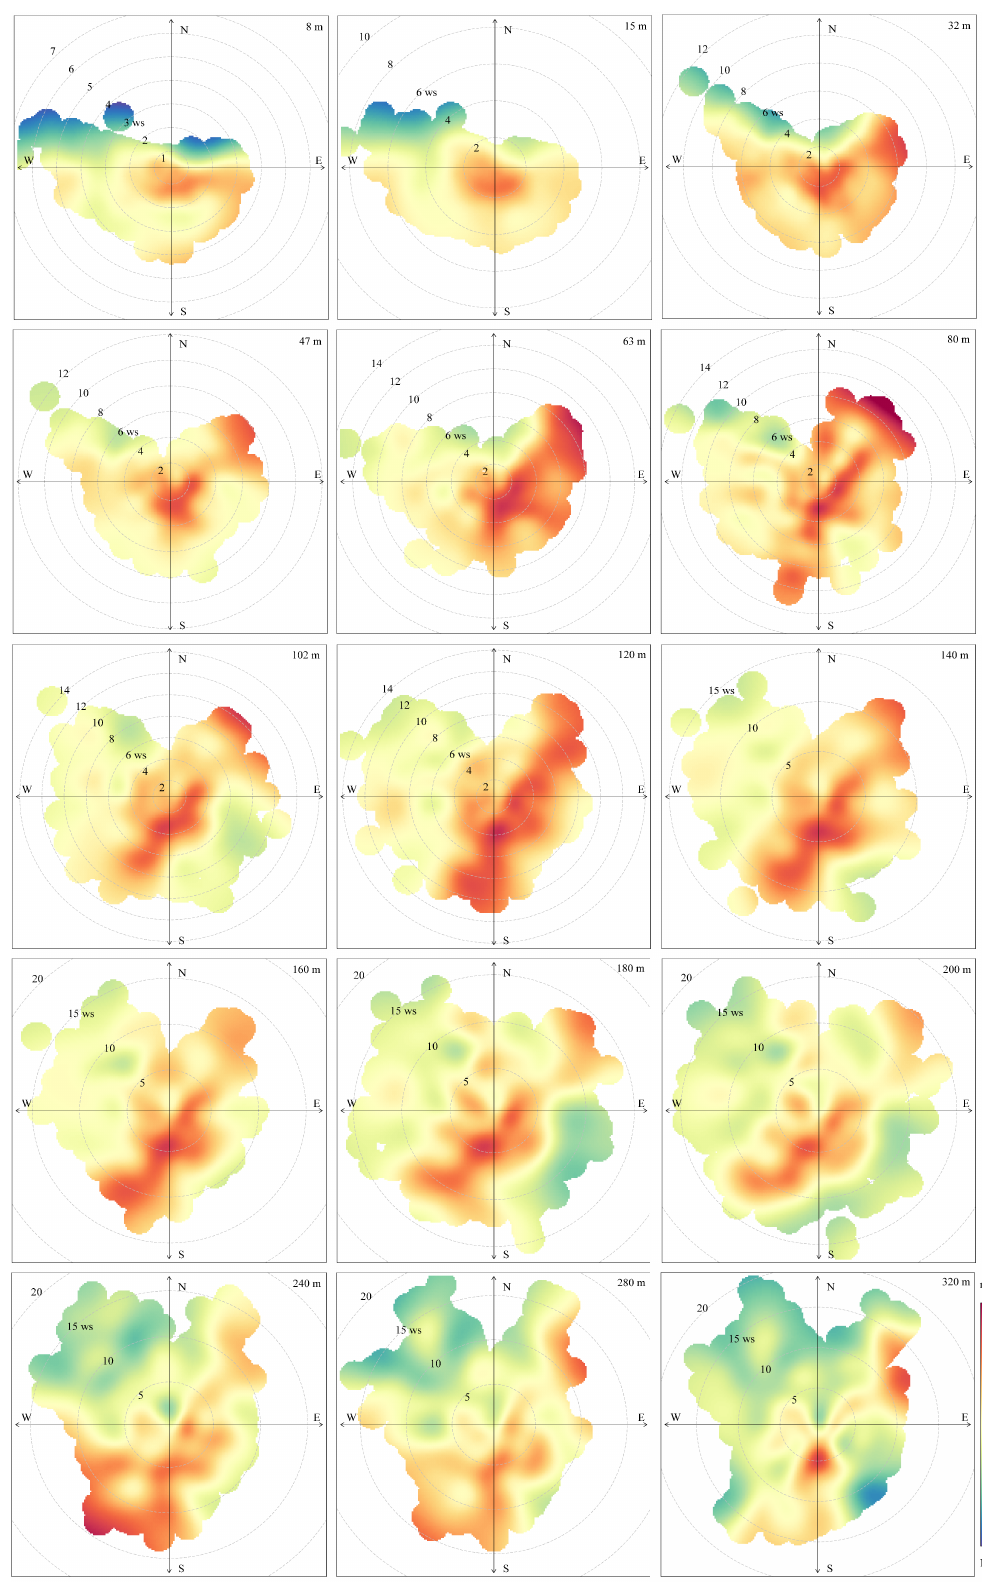
Figure 4. The frequency distributions of wind directions and NH 3 concentration for all height during the observation period. Radial data are WS (ms − 1 ) as a function of WD ( ◦ ). The colors denote the NH 3 concentrations (µgm − 3